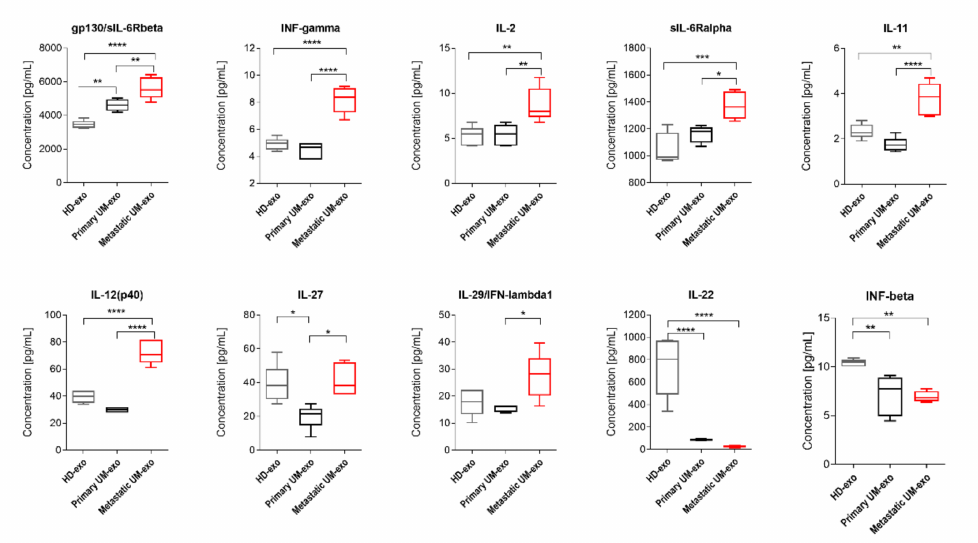
Figure 4. Box and whiskers plots present the concentration of interleukins and interferons detected in exosomes derived from healthy donors, primary and metastatic UM patients. Results are displayed as a median concentration in picograms per milliliter. The box and whiskers were calculated using the Tukey method. * p < 0.05, ** p < 0.01, *** p < 0.001, **** p > 0.0001: Based on one-way ANOVA or Kruskal–Wallis test with Dunn’s post hoc multiple comparison